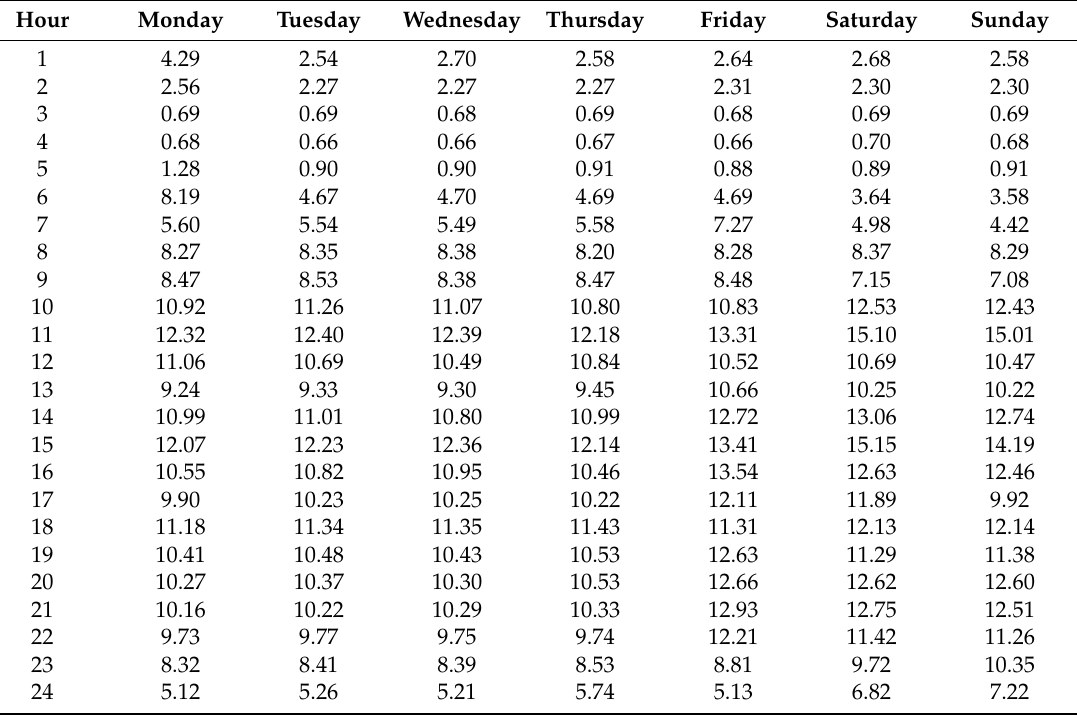
Table A4. Forecasted load of an industrial customer